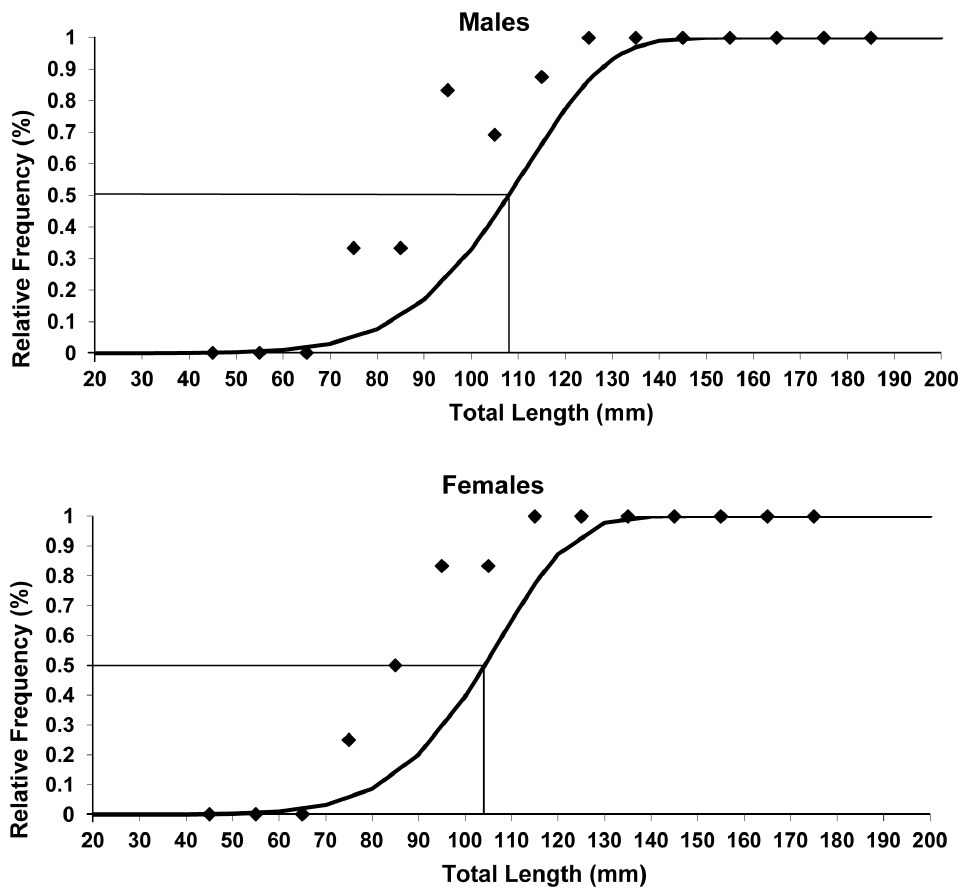
Figure 4. First gonad maturation size. First gonad maturation size of Brachyhypopomus gauderio . Distribution of the relative frequency of specimens in total length classes. Lines represent the point at which 50% of the individuals are considered adults. Number of males analyzed= 99. Number of females analyzed= 96.